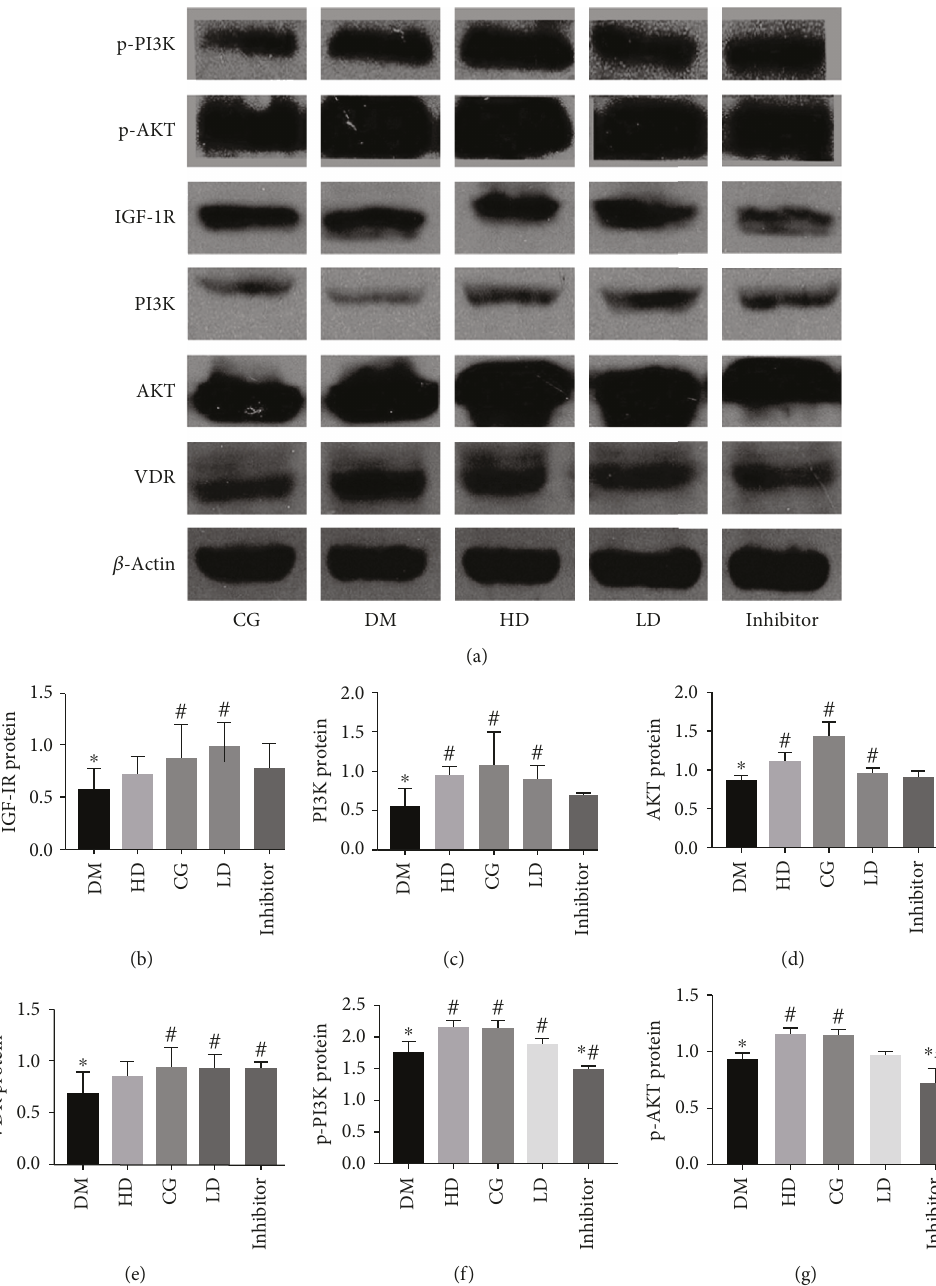
Figure 4: Protein expression levels of VDR, IGF-1R, PI3K, AKT, p-PI3K, and p-AKT in the rat testis. The protein expression levels of VDR and IGF-1R in the DM group were signi fi cantly lower than those in the CG group ( p < 0 05 ). The expression levels of VDR in the HD and LD groups were signi fi cantly higher than that in the DM group ( p < 0 05 ). The expression of IGF-1R in the LD group was signi fi cantly higher than that in the DM group ( p < 0 05 ). The expression of IGF-1R in the inhibitor group was signi fi cantly lower than that in the HD group. The expression levels of PI3K, AKT, p-PI3K, and p-AKT di ff ered signi fi cantly between the DM and CG groups ( p < 0 05 ). The expression levels of PI3K, AKT, p-PI3K, and p-AKT in the group treated with vitamin D were signi fi cantly higher than those in the DM group ( p < 0 05 ). The expression levels of PI3K, AKT, p-PI3K, and p-AKT were signi fi cantly di ff erent between the HD group and the inhibitor group ( p < 0 05 ). ∗ Compared with the CG group, p < 0 05 ; # compared with the DM group, p < 0 05